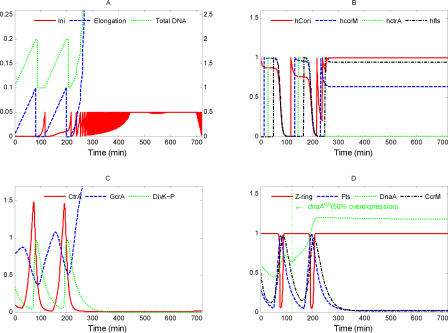
Simulation of dnaAop: k′′ = 0.00825 (50% of WT)